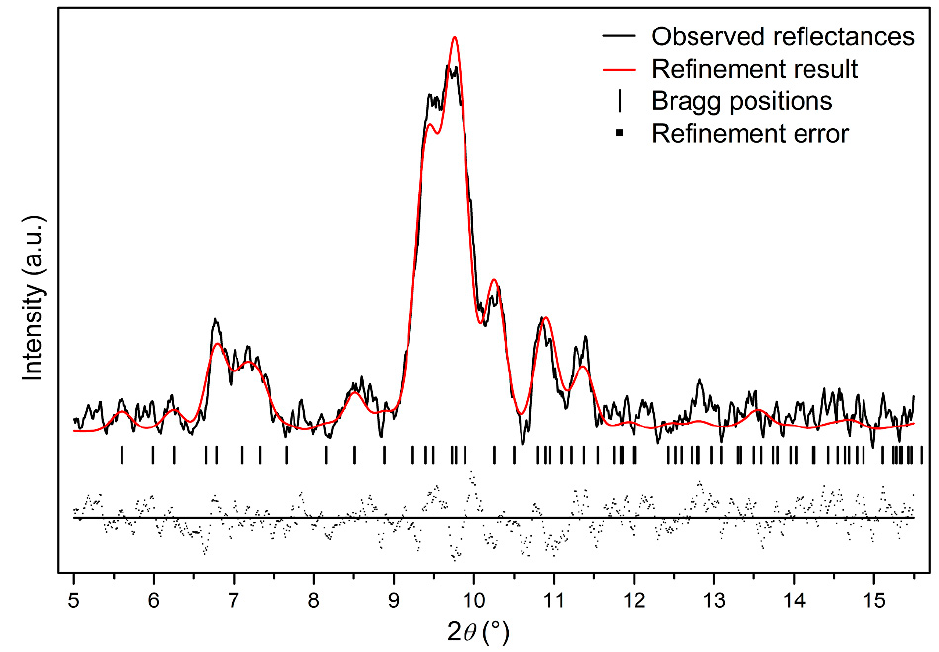
Figure 5. The refinement result for phase III of Ag 2 S nanosheets at 16.5 GPa, Rwp = 0.1921, Rp = 0.1402 and chi^2 = 67.78.